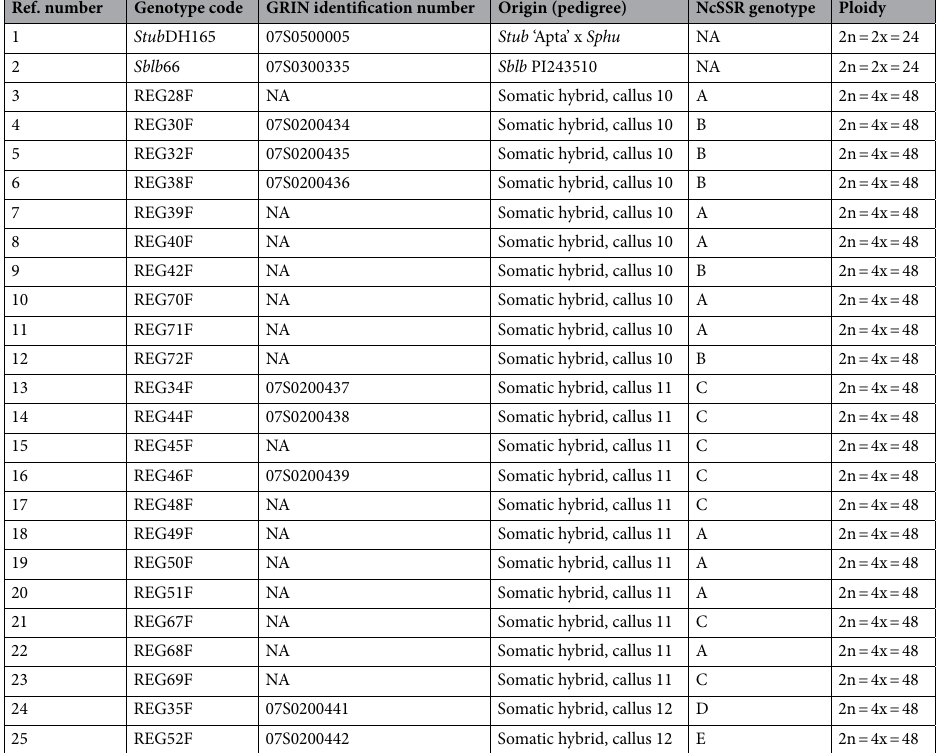
Table 1. Characteristics of parents and somatic hybrids. More associated data are available under accession numbers of GRIN database (http:// grinc zech. vurv. cz/ gring lobal/ search. aspx). The ncSSR genotype (A–E) refers on specific set of microsatellite alleles further characterized in Table 2. Sblb—Solanum bulbocastanum , Stub — S. tuberosum ssp. tuberosum ; Sphu — S.